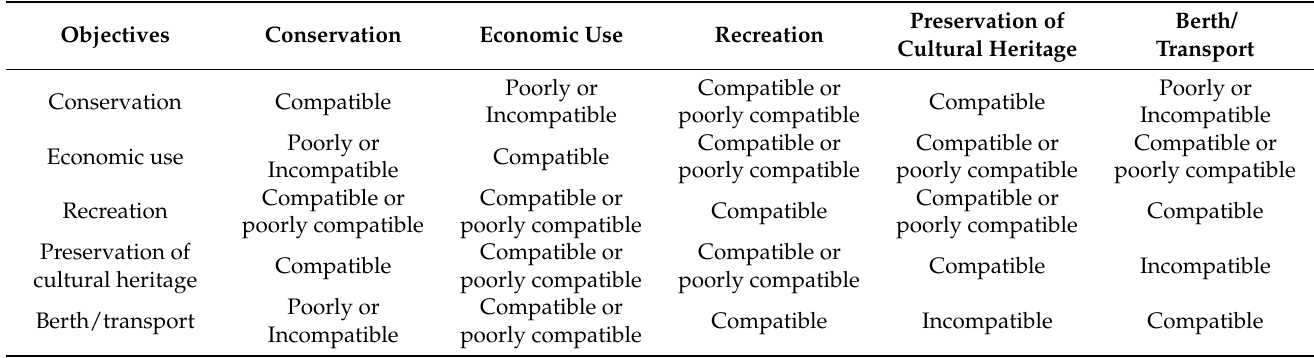
Table 3. Compatibility matrix between the objectives of the